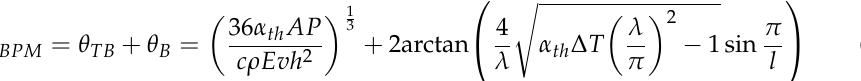
d Figure 9. Schematic diagram of thermal buckling about the compression bars and the comparison of the bending deformation about two methods: ( a ) schematic diagram of thermal buckling of hinged compression bars fixed at both ends, ( b ) deformation diagram of the traditional method and ( c ) deformation diagram of BPM.